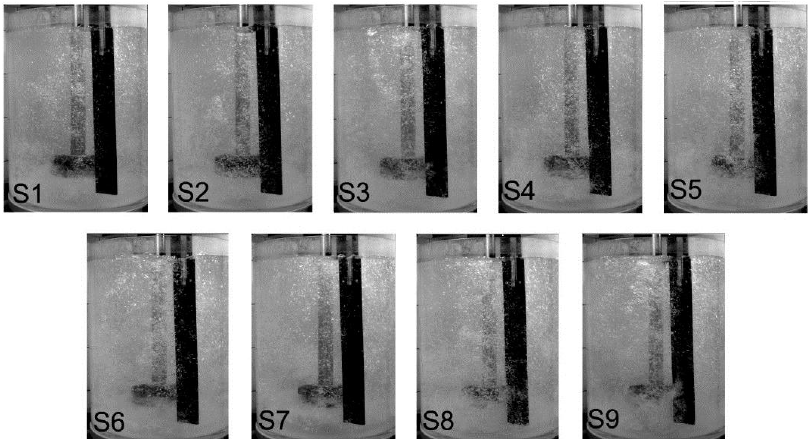
Figure 3. The level of dispersion registered for different processing parameters, according to Table 2, for the commercial design rotary impeller A.